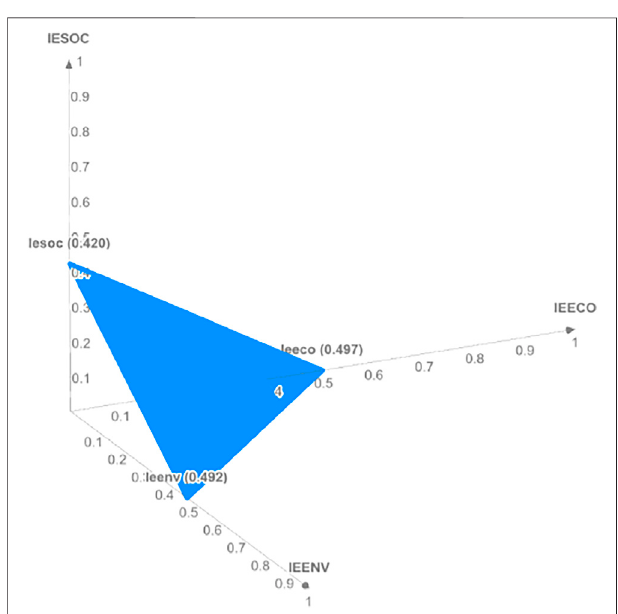
FIGURE 4 | Energy sustainable performance evaluation — indicator interpretation of q